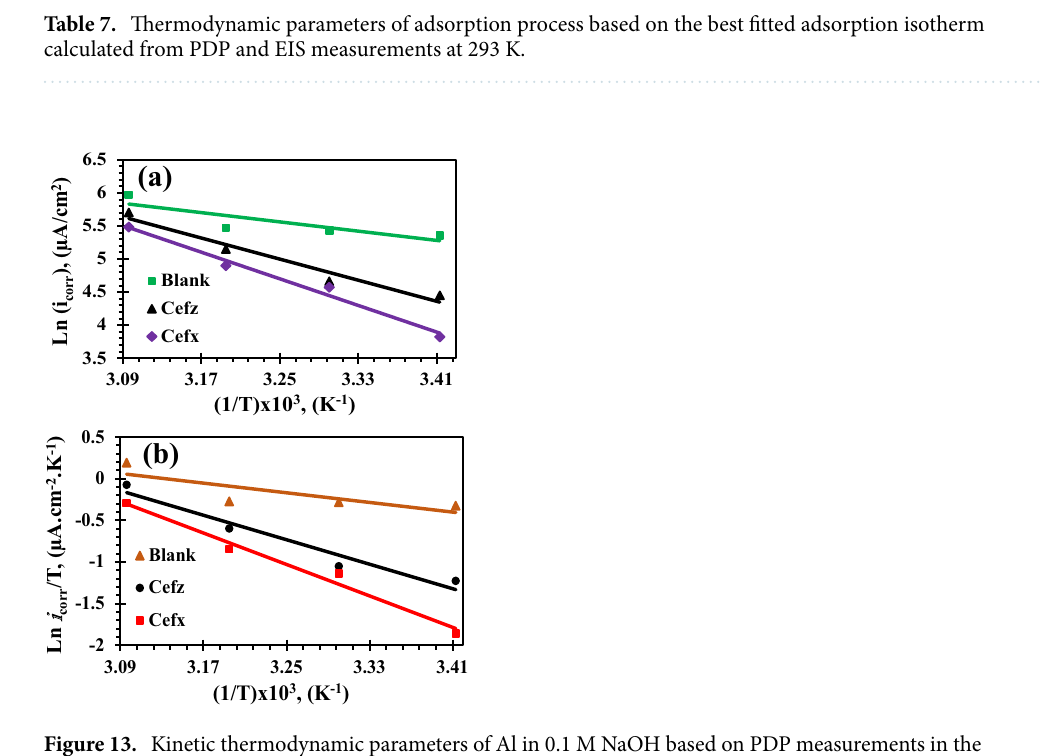
Figure 13. Kinetic thermodynamic parameters of Al in 0.1 M NaOH based on PDP measurements in the absence and presence of 300 ppm of Cefx and Cefz; ( a ) Arrhenius plots and ( b ) Transition state